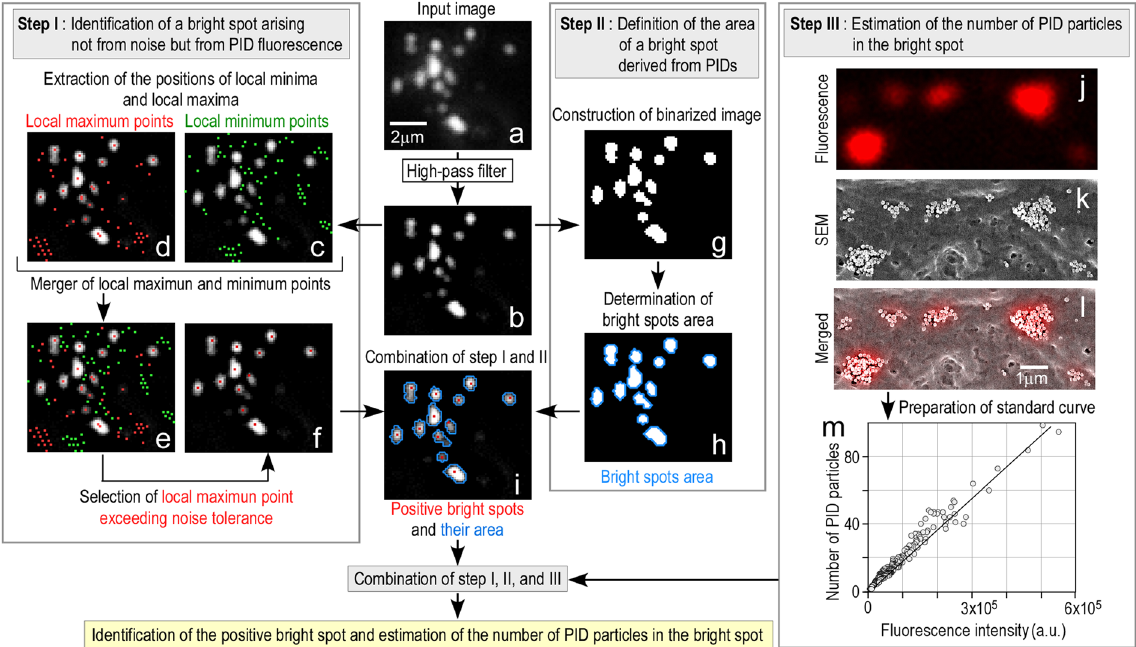
Figure 2. Image-processing method to measure the number of PID particles in an acquired image. This imaging-processing method consists of three main steps: (1) identification of a bright spot arising not from noise but from PID fluorescence (Step I), (2) definition of the area of a bright spot derived from PIDs (step II), and (3) estimation of the number of PID particles in the bright spot (step III). First, the input fluorescence image ( a ) was filtered with a high-pass filter ( b ). In step I, the high-pass-filtered image was scanned using a matrix filter of 3 × 3 pixels (Fig. 3a–c) to extract the positions of local minima ( c , green dots) and local maxima ( d , red dots). Then, a merged image was formed that showed the positions of both types of points ( e ). The region around each local maximum point was searched for the nearest local minimum point (Fig. 3d). We selected the local maximum point exceeding the “noise tolerance (Fig. 3d)” as a positive bright spot ( f ). The “noise tolerance” is a threshold value that shows that the brightness value of a local maximum point is higher than 32 (in the 12- bit image) relative to that of the corresponding local minimum point (Fig. 3d). In step II, a binarized image ( g ) was constructed from ( b ) by using a threshold value of 16 (in the 12-bit image), and then the bright spot area was determined ( h , blue line) from the binarized image ( g ). The positive bright spots acquired in step I ( f , red dots) and the bright area acquired in step II ( h , blue line) were combined ( i ). Bar, 2 μ m ( a – i ). In step III, the positive bright spots resulting from PIDs in human cancer tissue and their area were simultaneously imaged using fluorescence microscopy ( j ) and SEM ( k ). The patterns resulting from many positive bright spots (n = 443) were analyzed using both imaging methods ( l ). The data of both the fluorescence signals ( j ) and the particle number determined using SEM images ( k ) were combined ( l ), and a standard curve with high correlation (correlation coefficient, R = 0.98) was obtained ( m ). By combining steps I, II, and III, we identified positive bright spots and estimated the PID particle number per bright spot. Bar, 1 μ m ( j – l